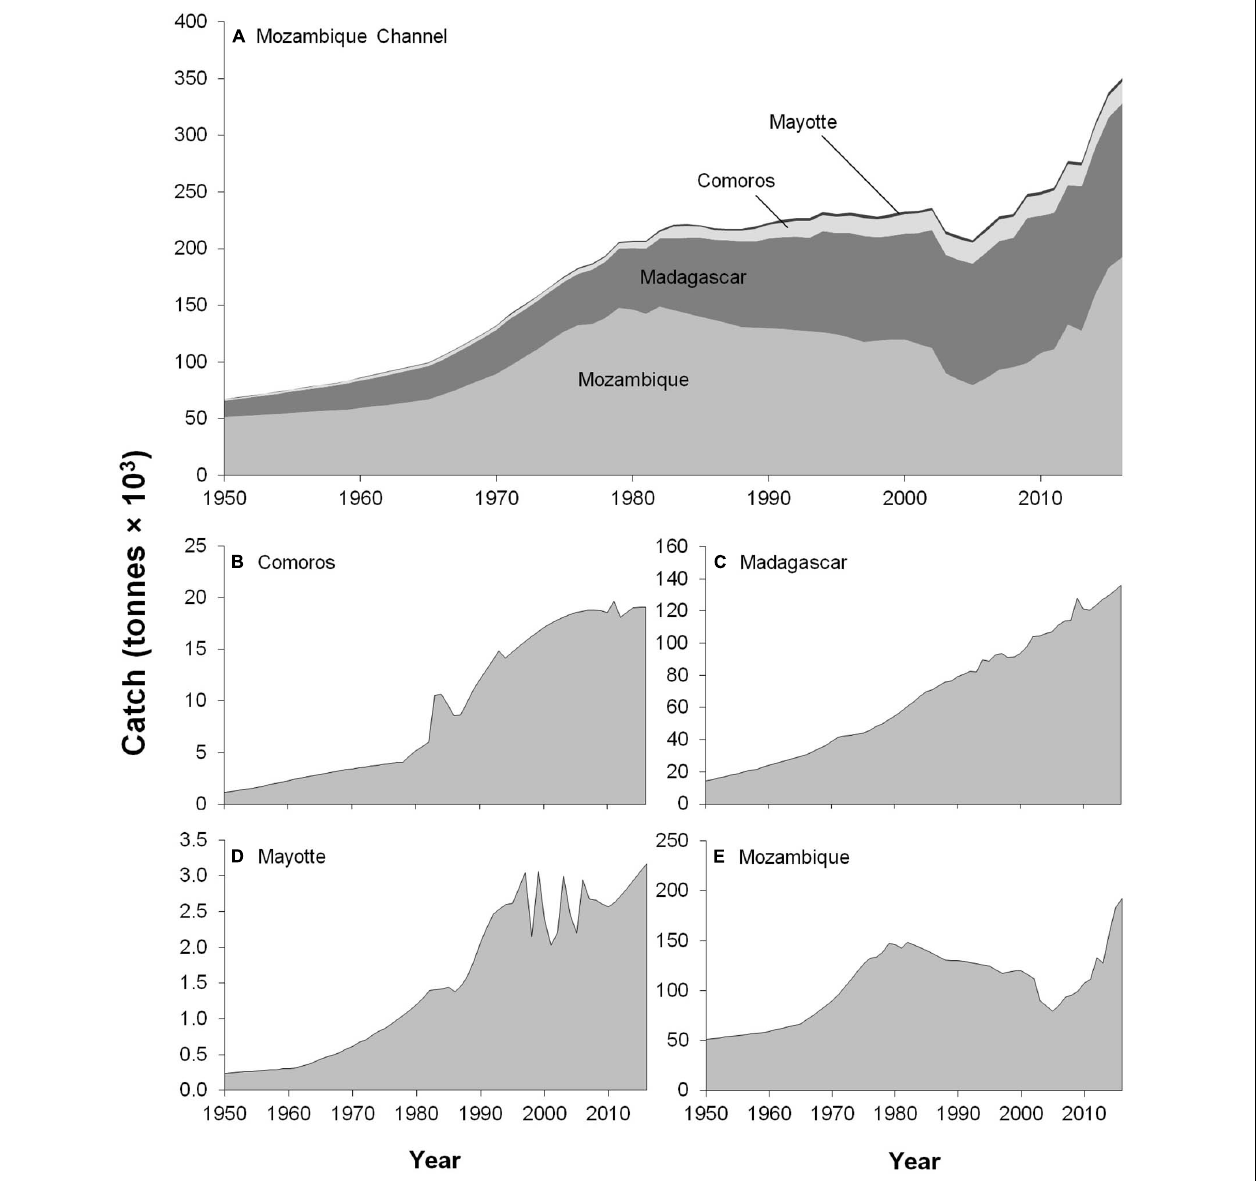
FIGURE 3 | Previously and independently reconstructed catches (tonnes × 10 3 ) for small-scale fisheries from 1950 to 2016 for (A) the Mozambique Channel region by country; (B) Comoros; (C) Madagascar; (D) Mayotte; and (E)